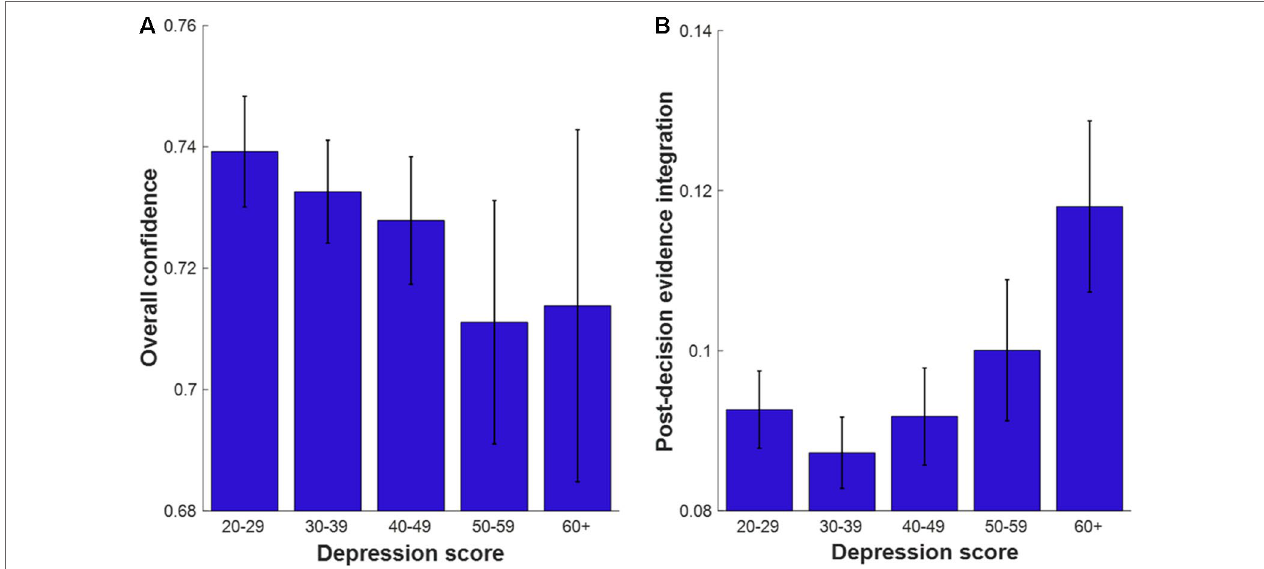
FIGURE 4 | Metacognitive variables plotted as a function of depression score in five bins (50 is the recommended cutoff classifying mild depression). Error bars indicate the standard errors of the mean. (A) Mean Overall confidence across depression bins. (B) Mean Postdecision evidence integration score across depression bins. Ns per bin: depression score 20–29 (n = 120), 30–39 (n = 135), 40–49 (n = 104), 50–59 (n = 41), 60+ (n =